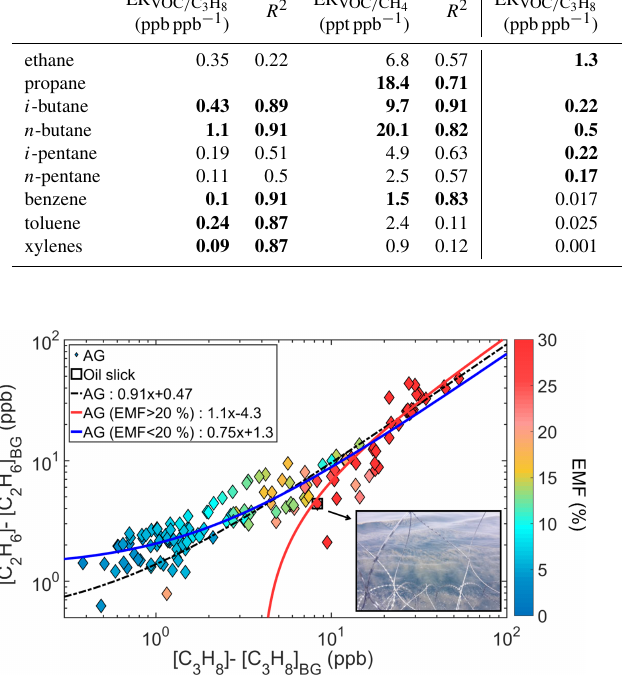
Figure 9. Excess mixing ratios of ethane and propane coloured by the excess NMHC mole fraction (EMF) of each sample for the area of the AG. The photo shows the oil slick as seen from the deck during the particular